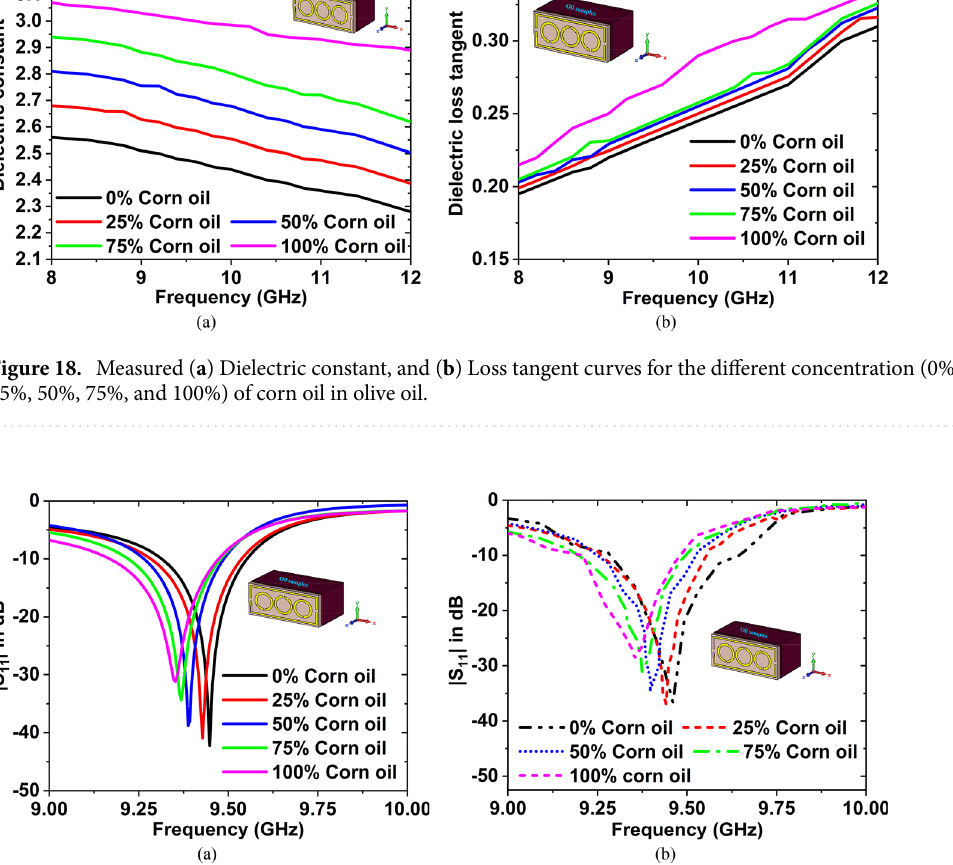
Figure 19. ( a ) Simulated, and ( b ) Measured S 11 curves for the different concentration (0%, 25%, 50%, 75%, and 100%) of corn oil in olive